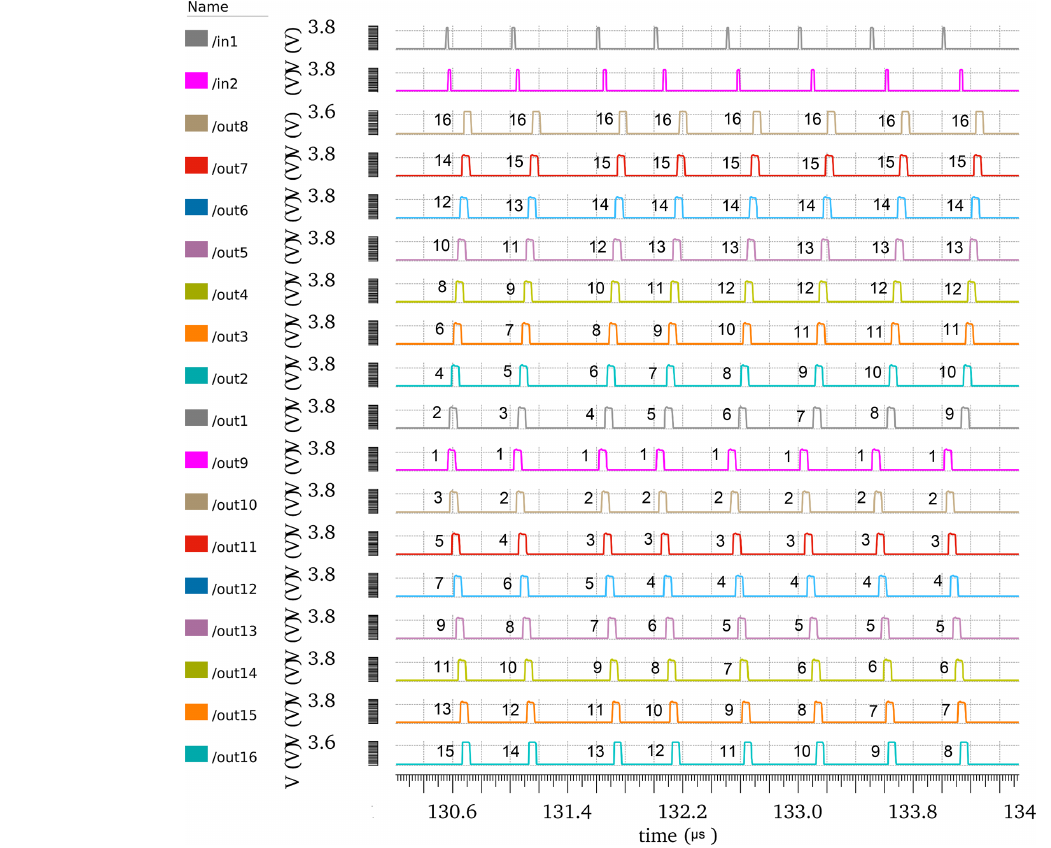
Figure 14. The simulation of ASRC rank coding, with in1 preceding in2. It represents the outputs of the ASDC at circuit conditions, where V dd is 3.3V, and temperature is 27 ◦ C and on the nominal process. They are coded by spike order codes. Every column represents a different code and reflects the difference in time amount between the two spikes at